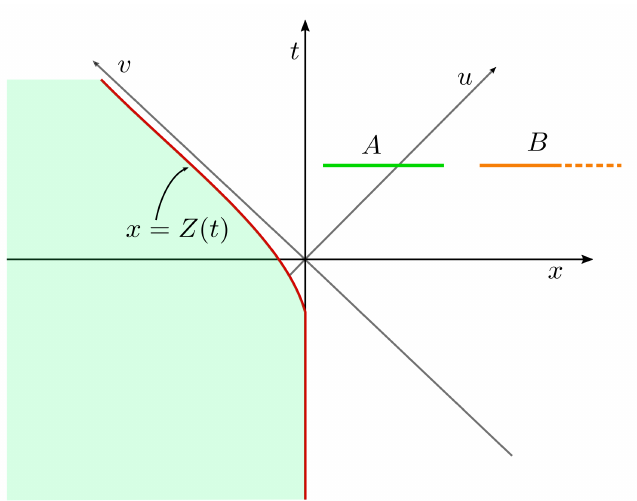
Figure 1. Schematics of two disjoint intervals A = [( t, x 1 ) , ( t, x 2 )] and B = [( t, x 3 ) , ( t, ∞ )] in the moving mirror BCFT. Figure modified from [60].